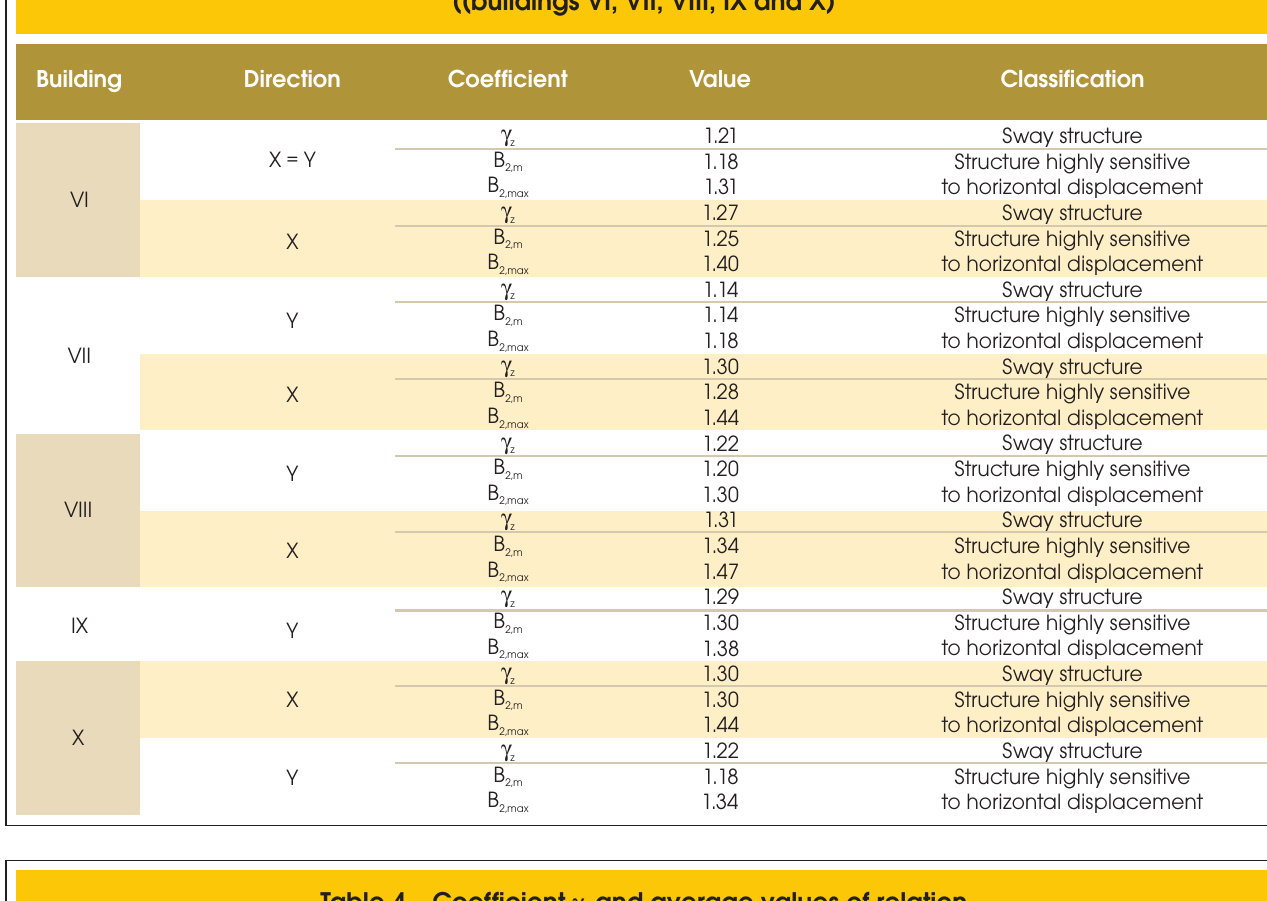
Table 3 – Values of the coefficients g and B , and classification of the structures z 2 ((buildings VI, VII, VIII, IX and X)